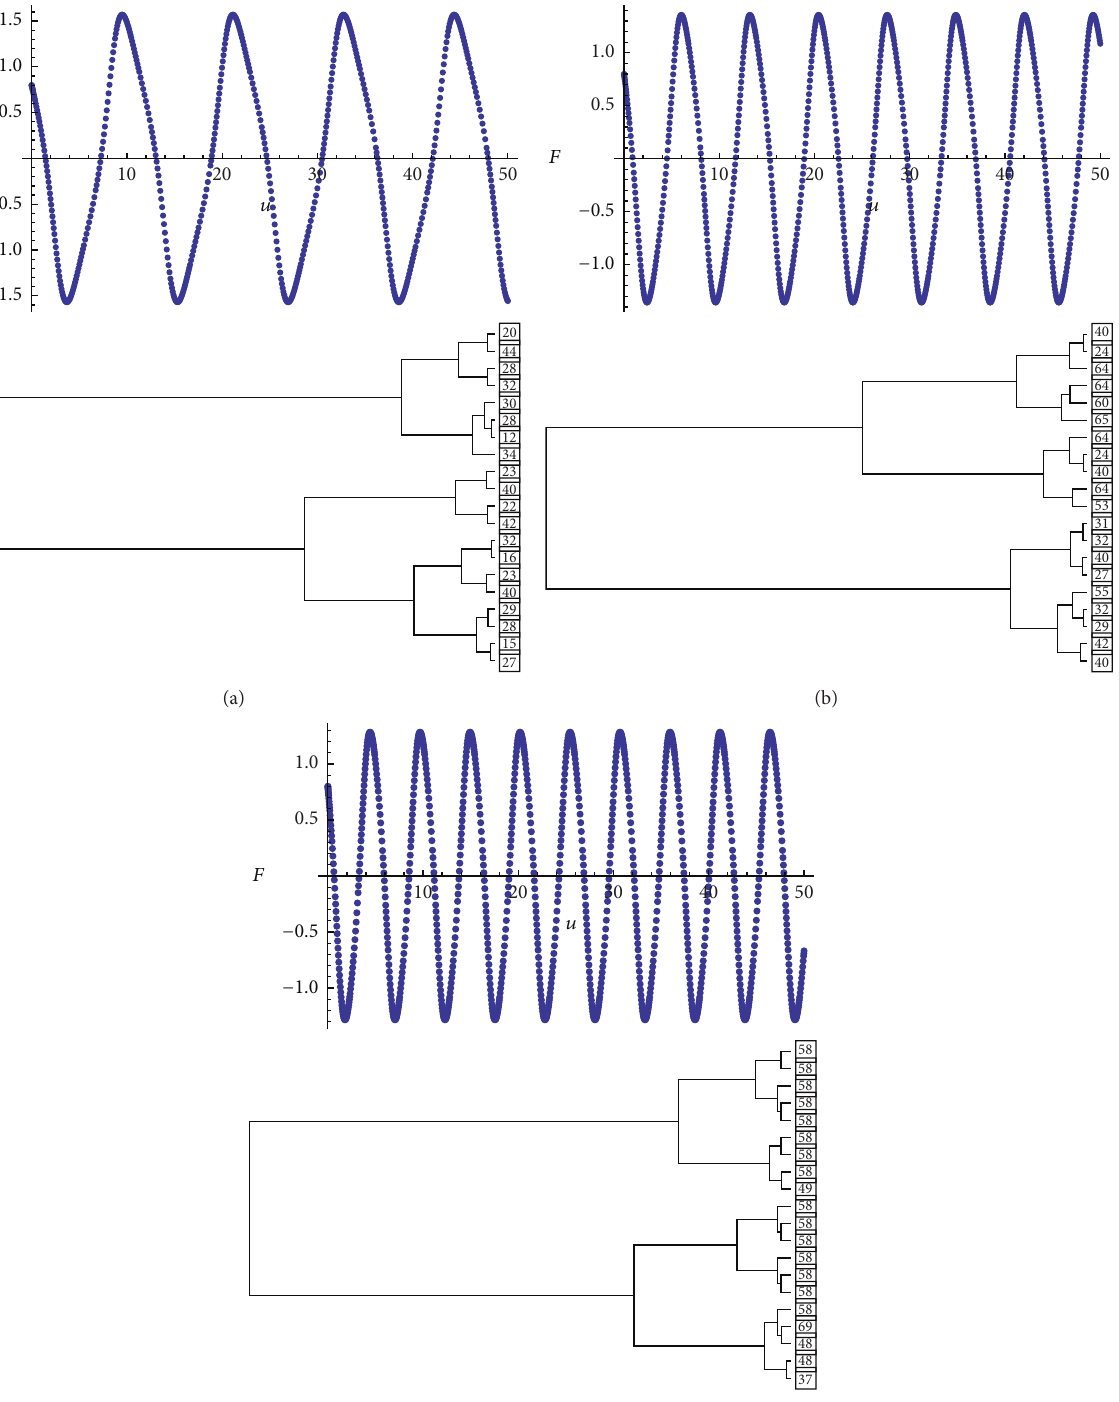
Figure 5: Time series and the resulting dendrogram from hierarchical clustering of TNDES for (a) 𝛽 = 0.5 , (b) 𝛽 = 1 , and (c) 𝛽 = 1.5